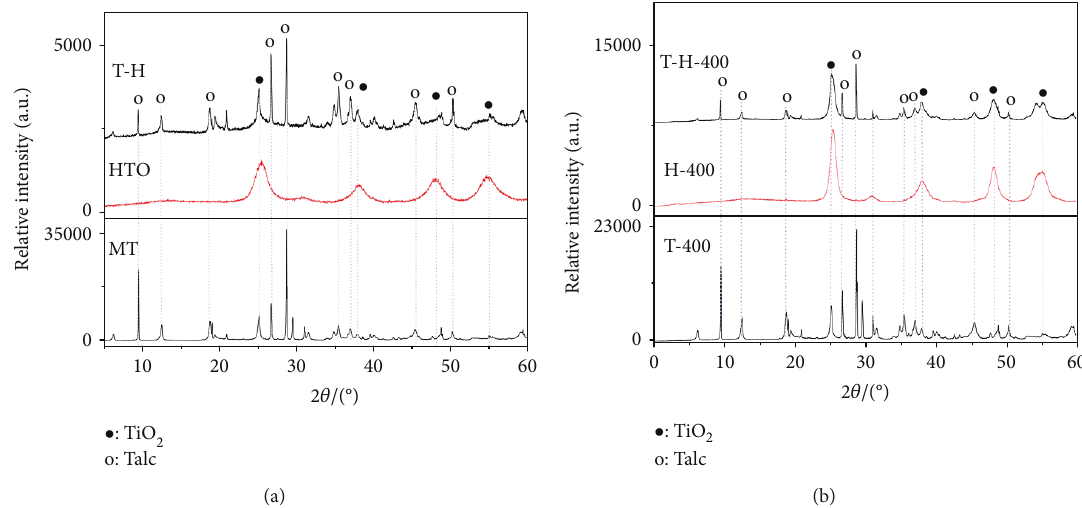
Figure 1: XRD spectra of samples ((a) XRD spectra of samples: MT, HTO, and T-H; (b) XRD spectra of samples: T-400, H-400, and T-H-400).